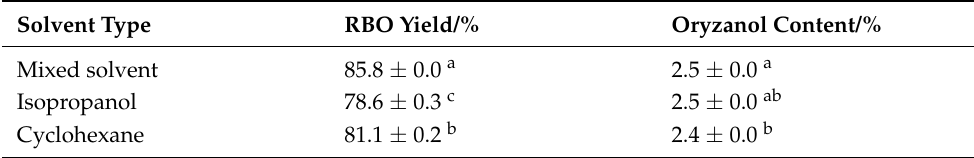
Table 3. Effect of different solvents on RBO yield and oryzanol content of RBO.